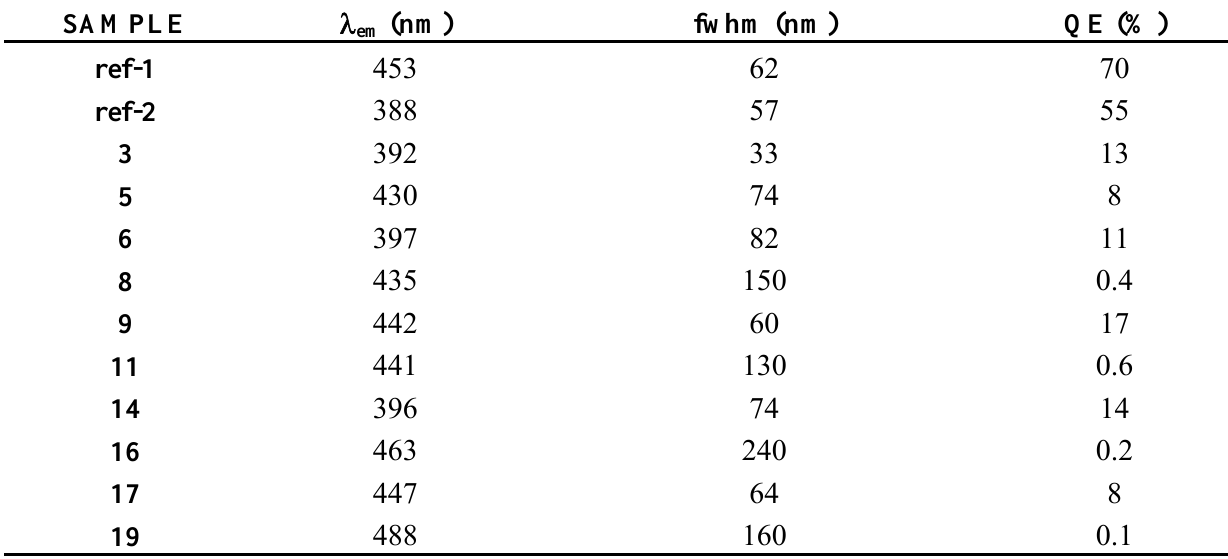
Table 1. Spectral characteristics of references and coumarin derivatives excited at 337